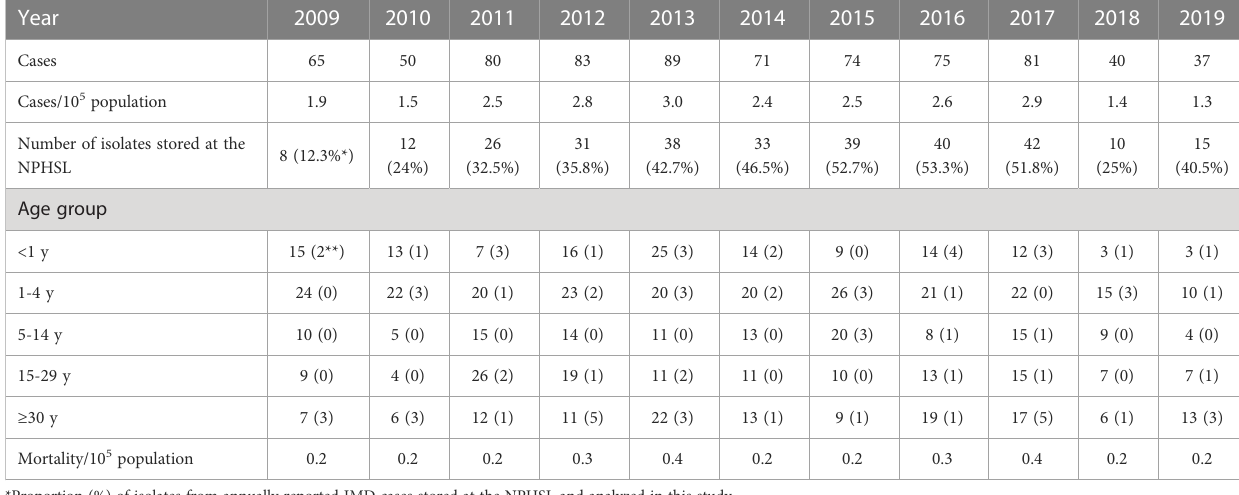
TABLE 2 Serogroup distribution of N. meningitidis isolates by year.